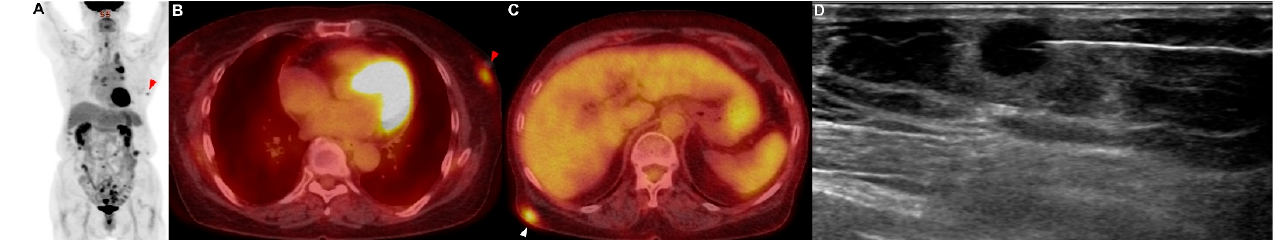
Figure 3. Patient 3: a 79-year-old woman diagnosed with lung adenocarcinoma with metastases in subcutaneous tissue. ( A – C ) The PET/CT showed a metastatic lesion (red arrowhead) in the left breast. I PET/CT showed a metastatic lesion (white arrowhead) in the subcutaneous layer of the middle part of the right back. ( D ) The core needle biopsy was performed on the lesion of the left breast.